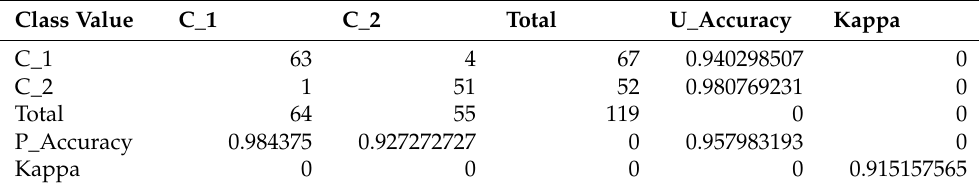
Table 5. Confusion Matrix (SVM